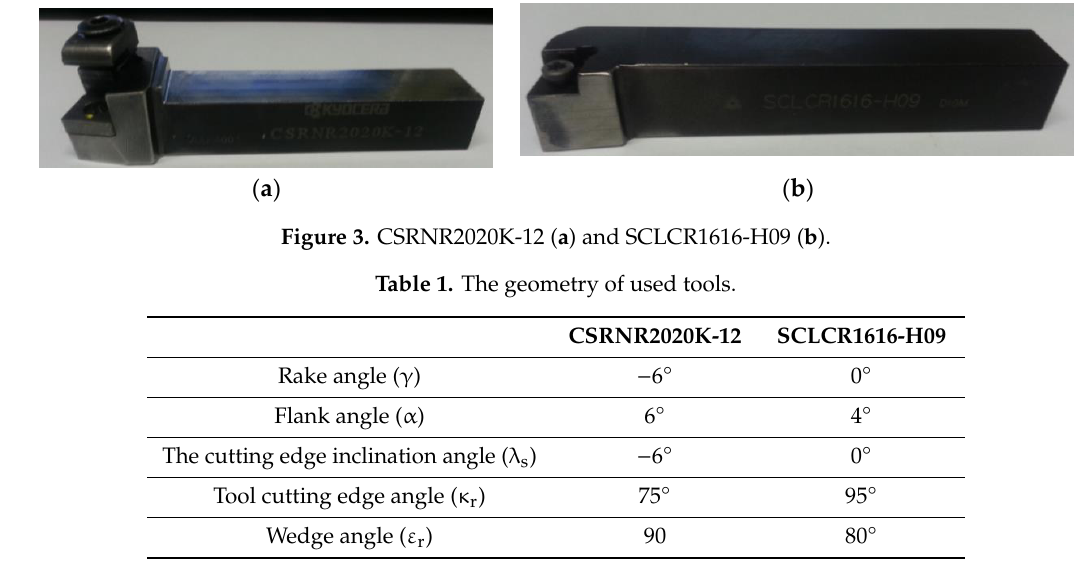
Figure 3. CSRNR2020K-12 ( a ) and SCLCR1616-H09 ( b ).